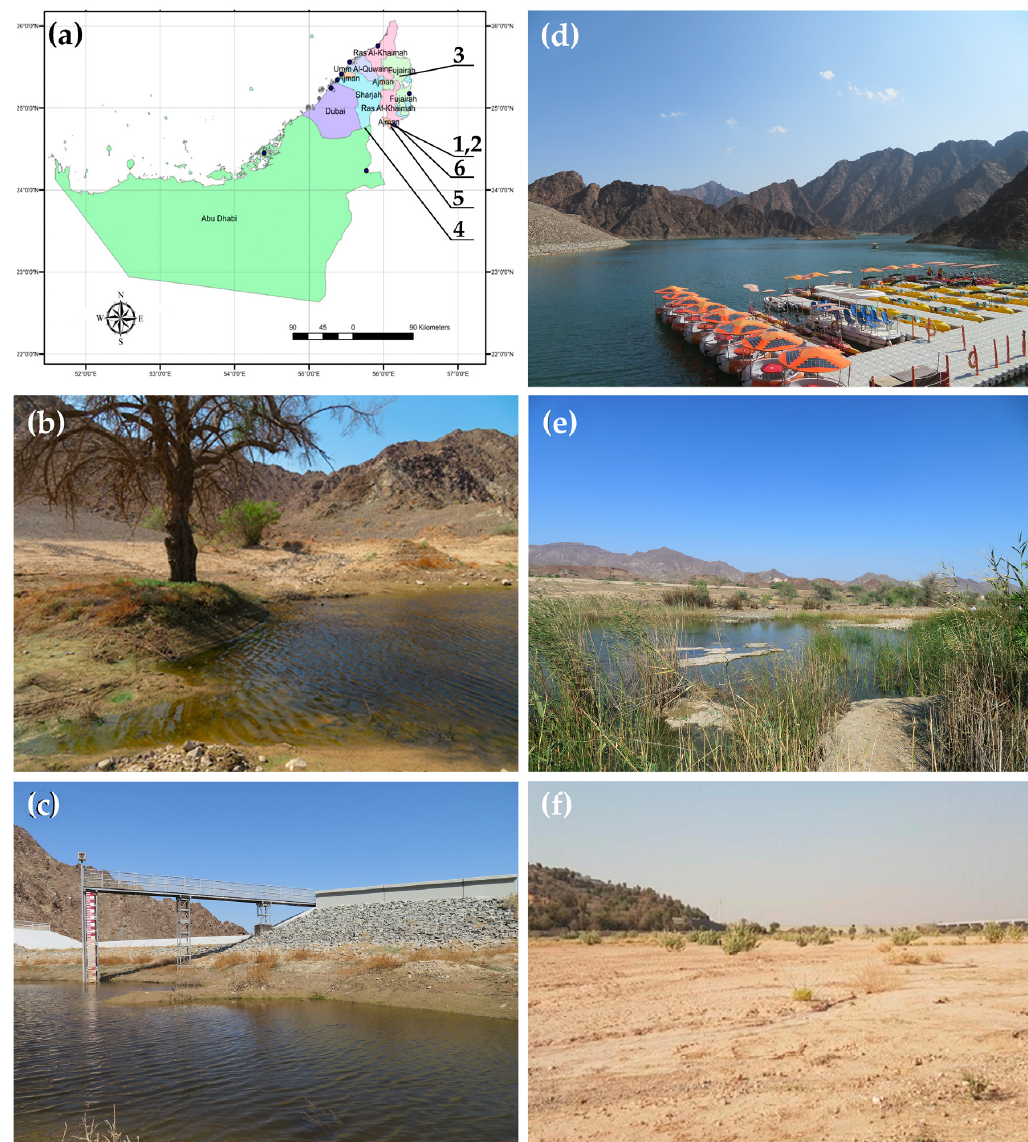
Figure 1. Map of UAE with sampled sites ( a ) and photos of the sites on 28 October 2019: ( b ) locality 1: Kholaiban Dam Masfut 1; ( c ) locality 2: Kholaiban Dam Masfut 2; ( d ) locality 5: Hatta Dam; ( e ) locality 6: Sheikh Maktoum Bin Rashid Al Maktoum Dam; ( f ) locality 4: Al Shuwaib Dam, dried at time of sediment collection. Table 1. List of localities where the different taxa were collected.